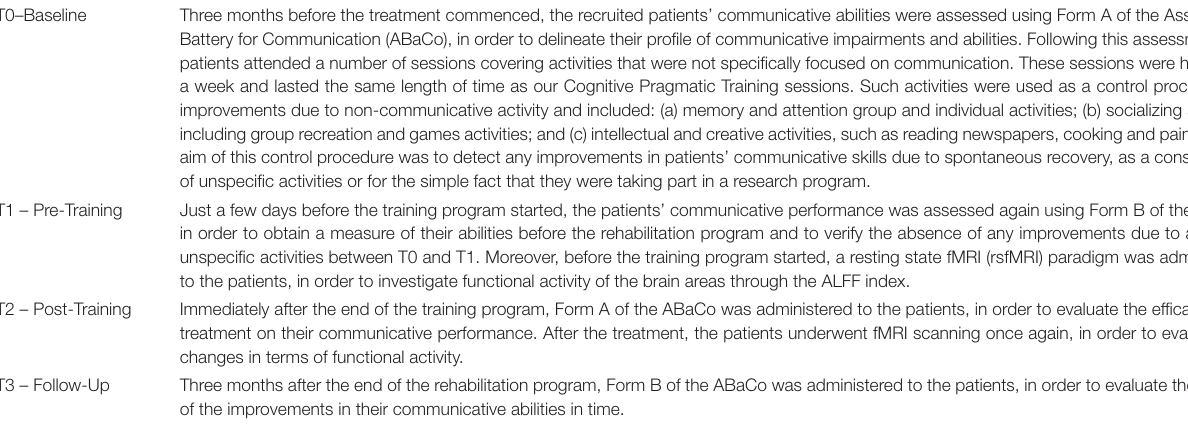
TABLE 1 | Description of the assessment phases that made up the experimental design